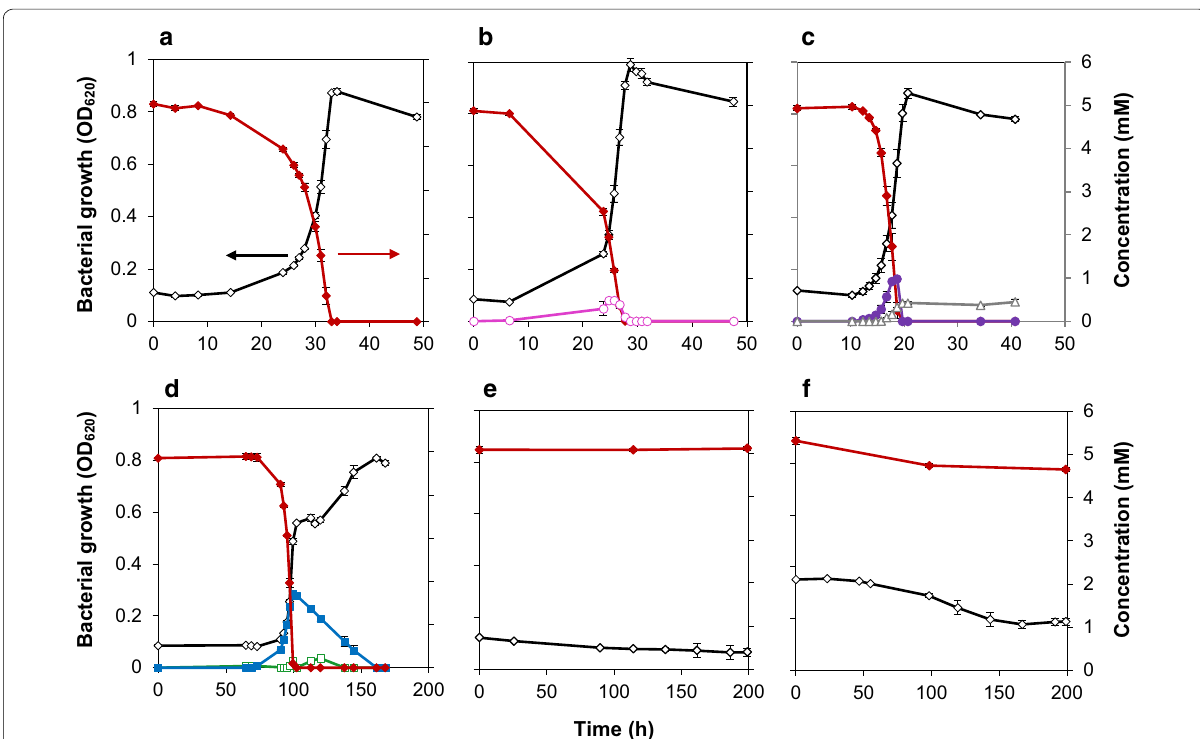
Fig. 2 Growth of Pseudomonas sp. isolate 9.1 on a ferulate, b p ‑coumarate, c benzoate, d vanillin, e syringate and f guaiacol as the only source of carbon. Experiments were performed in duplicates and the standard deviations are displayed with an error bar. The OD and model compounds concentration (mM) are shown in black open diamond and red closed diamond respectively. The excreted intermediate compounds, if any, are also shown (Read from right axis). Pink open circle, 4‑hydroxybenzoate; Violet closed circle, catechol; Grey open triangle, cis , cis ‑muconate; Blue closed square, vanillyl alcohol; green open square,